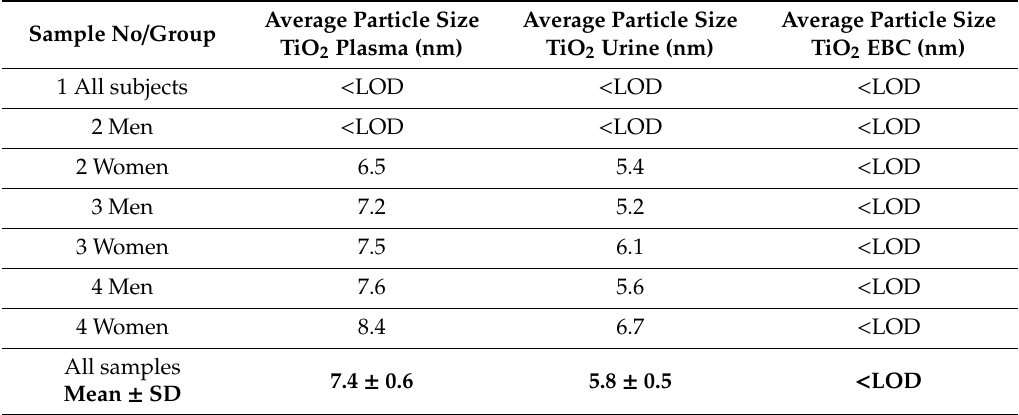
Table 4. Particle size distribution (PSD) of TiO 2 measured in plasma, spot urine, and exhaled breath condensate (EBC) in study A (sunscreen). Resolution 1 nm.